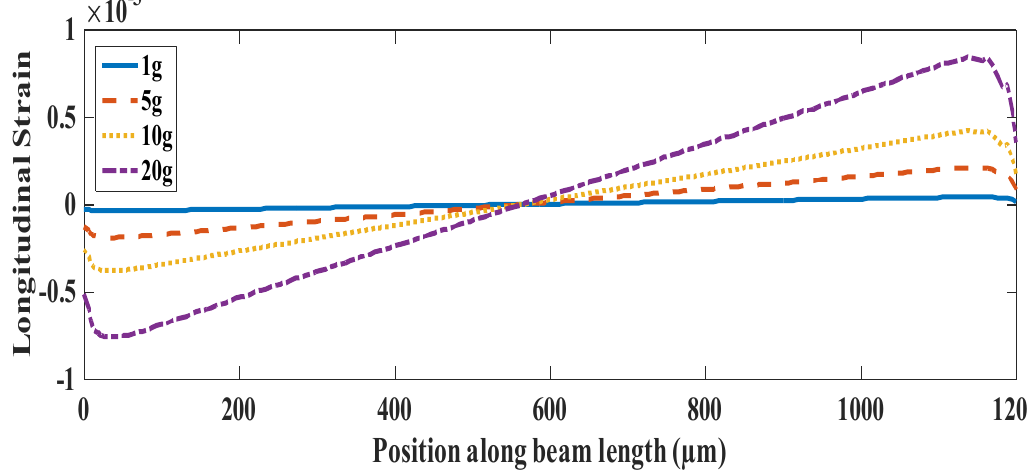
Figure 8. Longitudinal strain for different parallel accelerations.